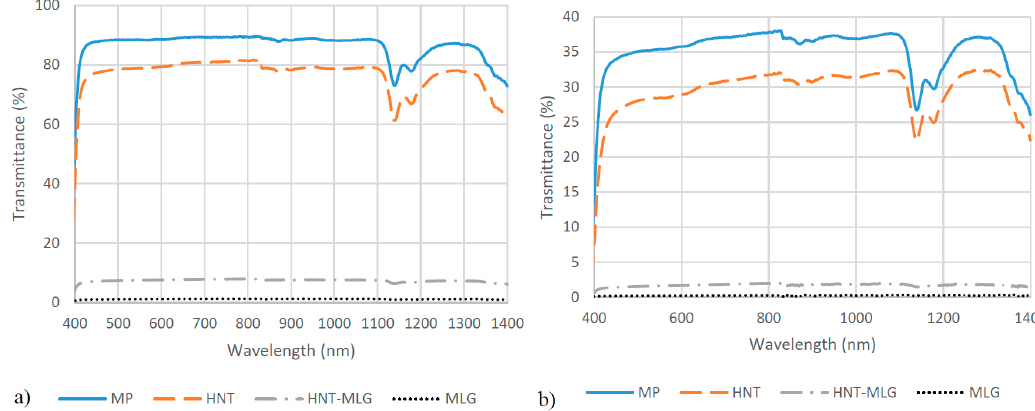
Figure 6. Optical transmittance of nanocomposites for dry conditions ( a ) and after water exposure ( b ).